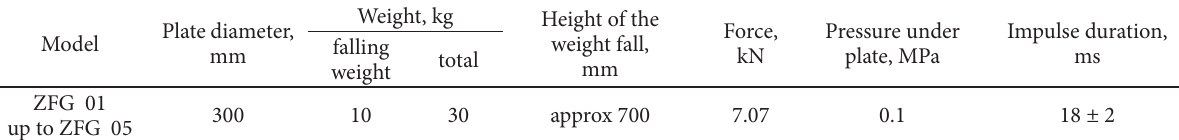
Table 1. Parameters of LFWD ZFG Plate diameter, Model